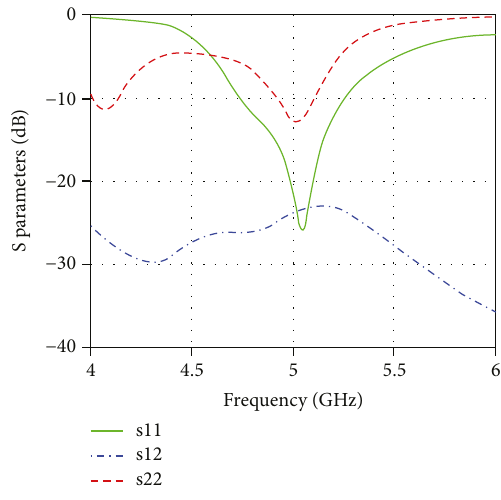
Figure 3: S parameter curve of the